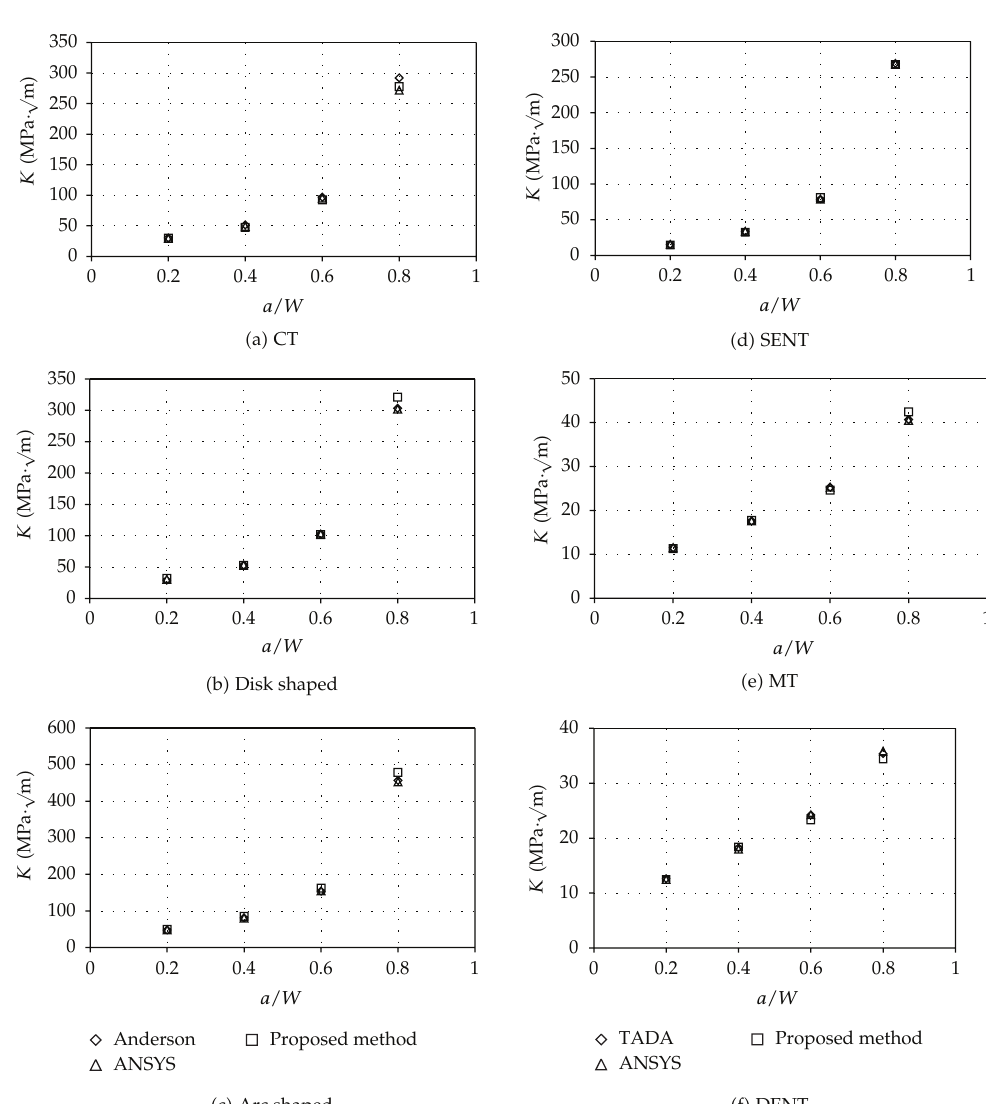
Figure 10: Stress intensity factors for (cid:2) a (cid:3) CT, (cid:2) b (cid:3) Disk-shaped, (cid:2) c (cid:3) Arc shaped, (cid:2) d (cid:3) SENT, (cid:2) e (cid:3) MT, (cid:2) f (cid:3) DENT